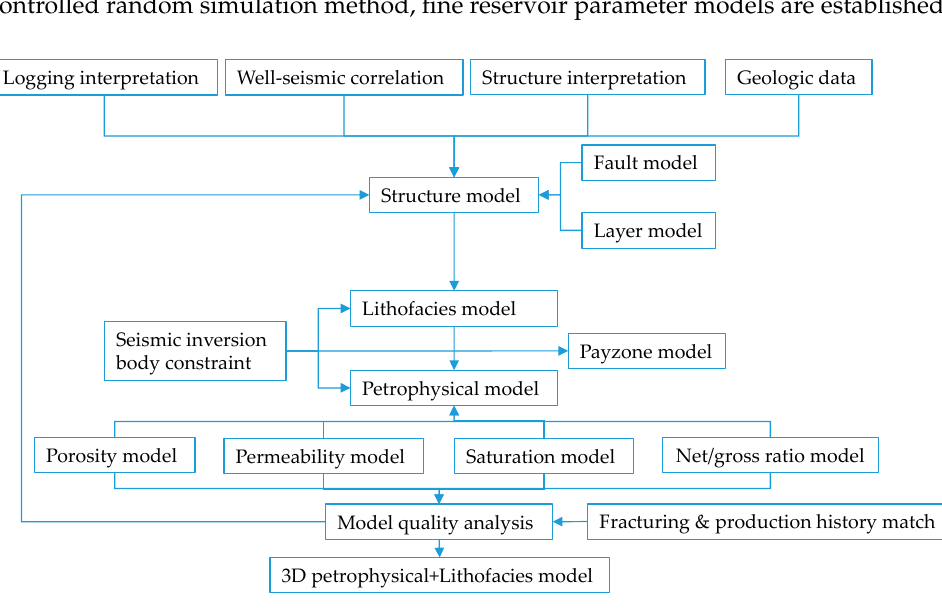
Figure 3. Workflow of the fine 3D geomechanical model. 3. Geomechanical Property Modeling for a Typical Reservoir 3.1. Overburden Pressure Figure 4 shows the overburden pressure modeling workflow. As shown in Figure 4a–c, the overburden pressure is density-integral. According to the density curve from the ground to the bottom of the well fitted by a single well, density modeling is carried out in combination with the 3D geological model grid to obtain the density body from the ground to the target layer in the whole region; then, the three-dimensional overburden